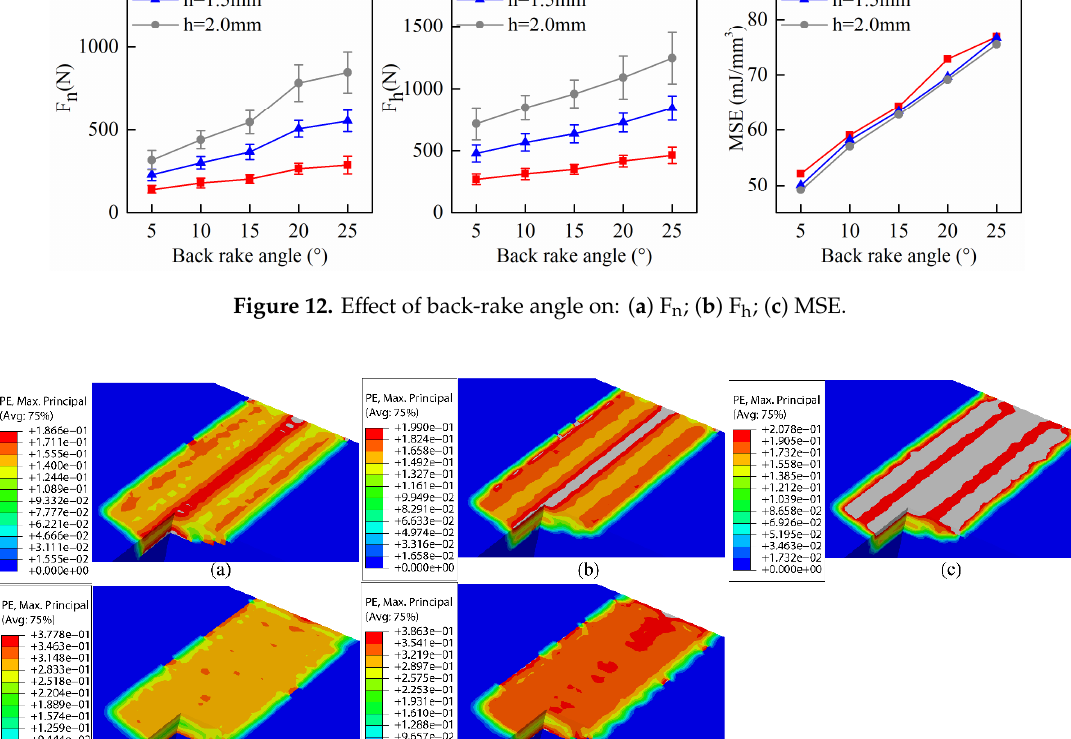
Figure 13. Plastic strain in rock-cutting process: ( a ) α = 5°; ( b ) α = 10°; ( c ) α = 15°; ( d ) α = 20°; ( e ) α = 25°.